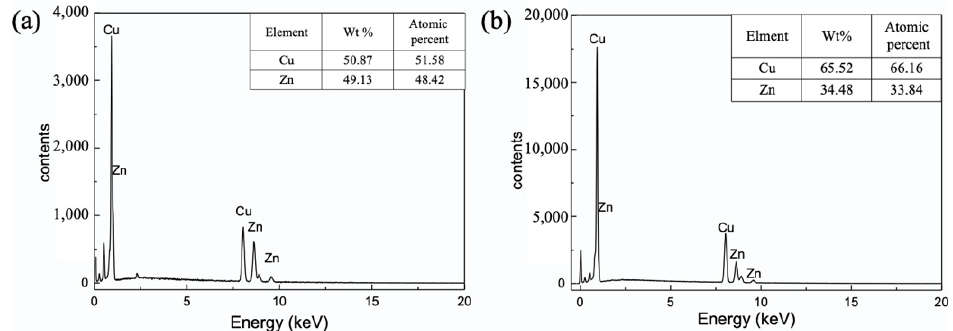
Figure 3. EDS patterns of the copper surfaces dealloyed by a H 2 SO 4 solution for ( a ) 5 min and ( b ) 30 min.